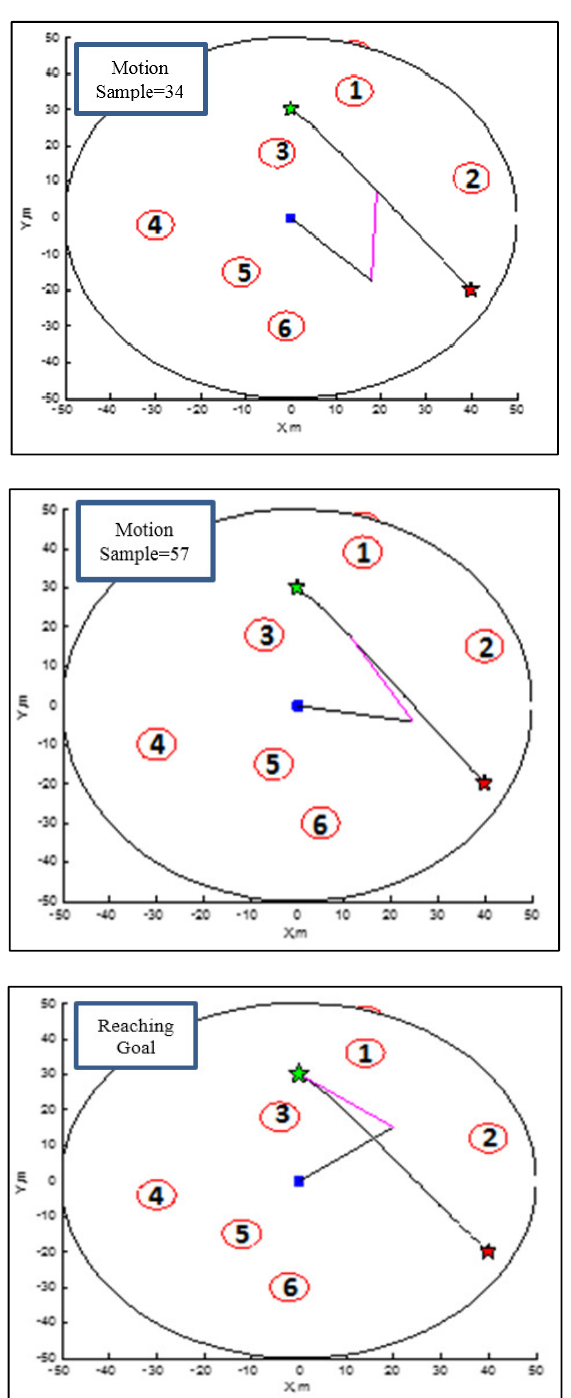
Fig. 15. The two-link robot arm result for the D* based on PSO path for the second environment.